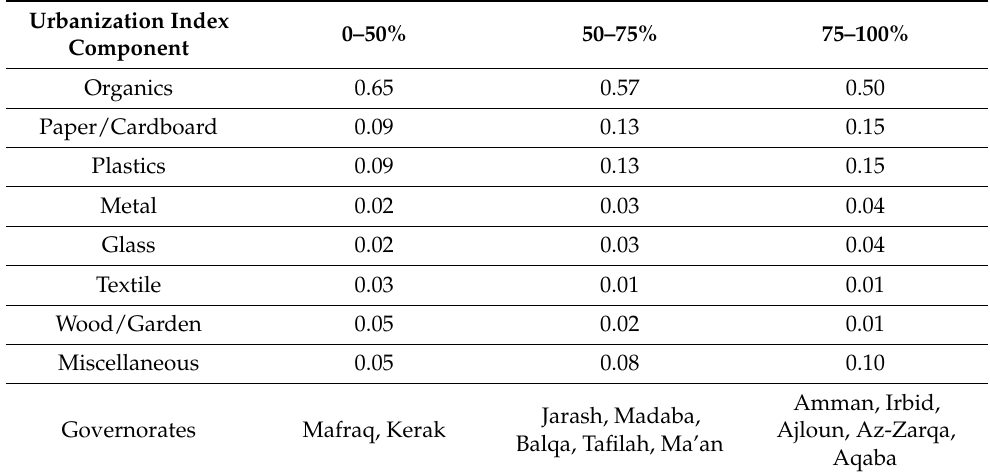
Table 1. MSW composition based on level of urbanization